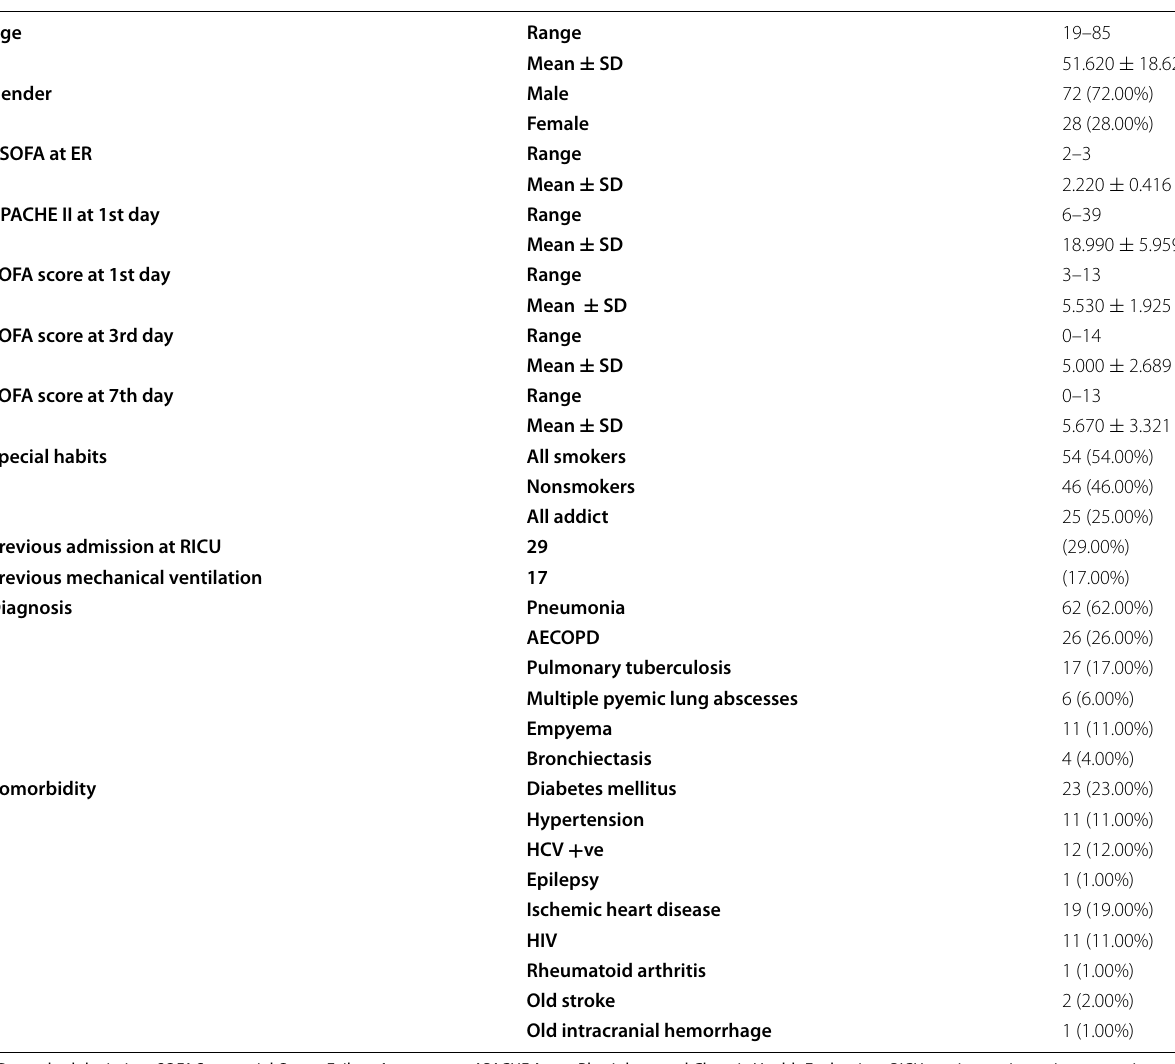
Table 1 Demographic data and scores of sepsis